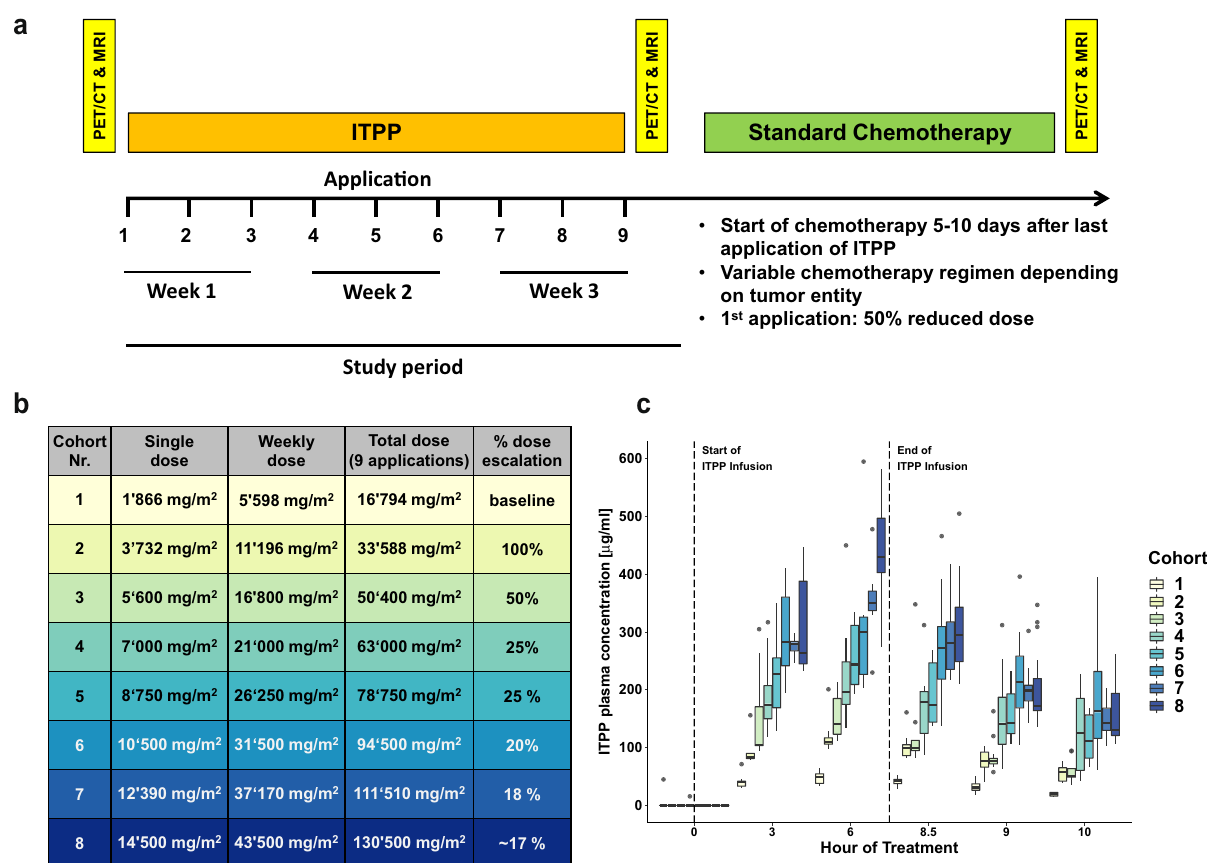
Fig. 1 Study setup and pharmacokinetics. a Schema of study fl ow with timepoints of ITPP administration and assessments. b Dose-escalation schema with single, weekly, and total doses for different cohorts. c Boxplots displaying median plasma concentrations at start of infusion (hour 0), 3 and 6 h as wells as 30 min, 1 and 2 h after end of intravenous ITPP administration (hour 8) of increasing doses in cohorts on treatment days. Upper and lower ends of boxplots represent 25 th and 75 th quartiles. Whiskers extend to values within 1.5 * IQR from the boxplot, with data beyond plotted separately as outliers ( n = 3 – 4 patients per cohort with 1 measurement performed in technical duplicates per timepoint for each treatment day (normally 9) per Hypomagnesemia and hypophosphatemia (all CTCAE grade I)